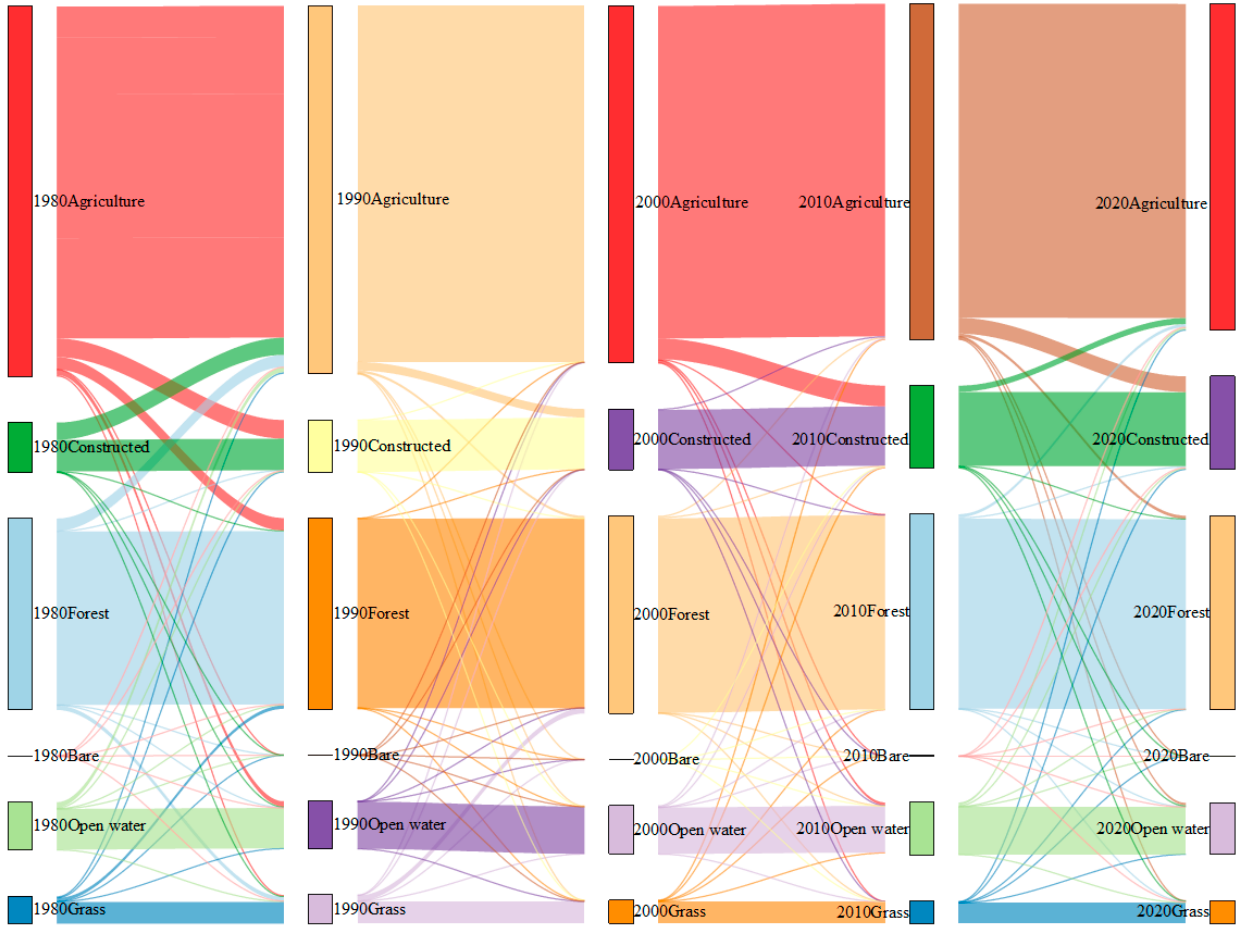
Figure 3. Sankey diagram map of land use transfer in the Yang tz e River Delta.